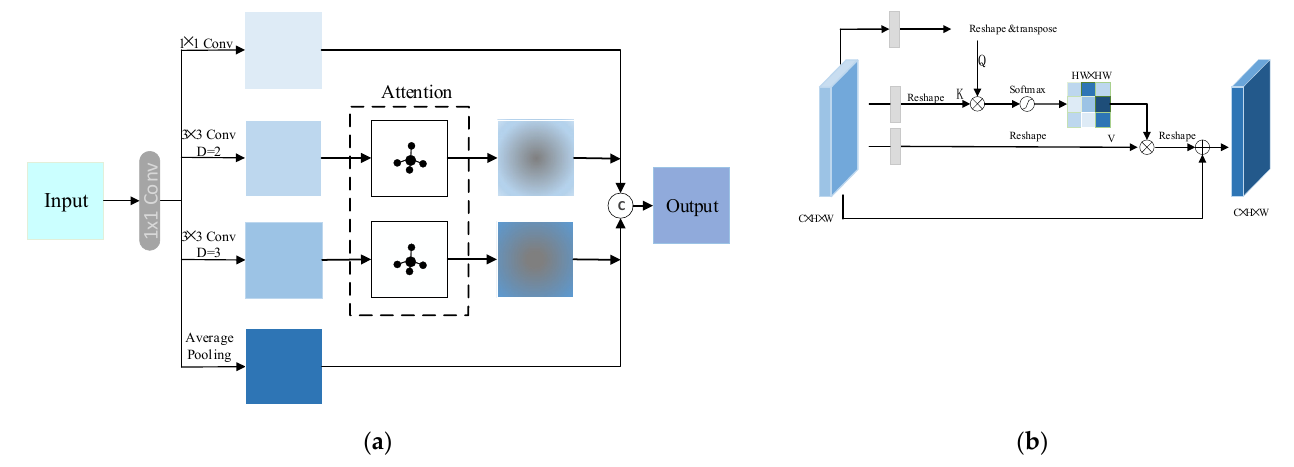
Figure 5. ( a ) Our proposed SAFEB and ( b ) the structure of the self-attention mechanism. We first load the input low-level feature maps in parallel to the dilated convolution layers with different dilation rates to extract rich features, then add self-attention mecha-